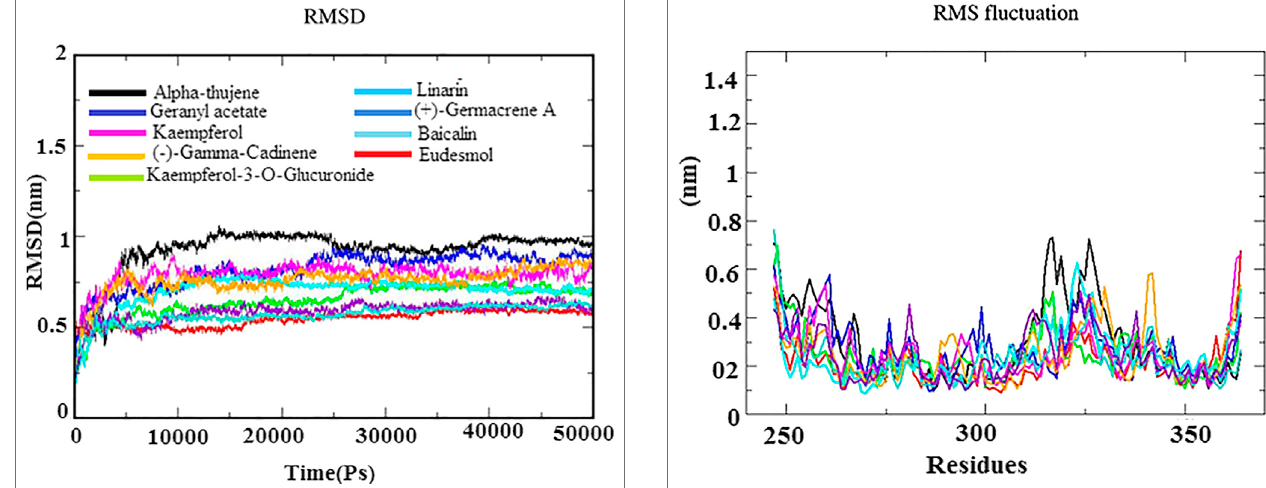
FIGURE 4 | RMSD backbone plot for N-protein – inhibitor complexes (nine complexes) during 50 ns simulation as a function of timescale in ps.